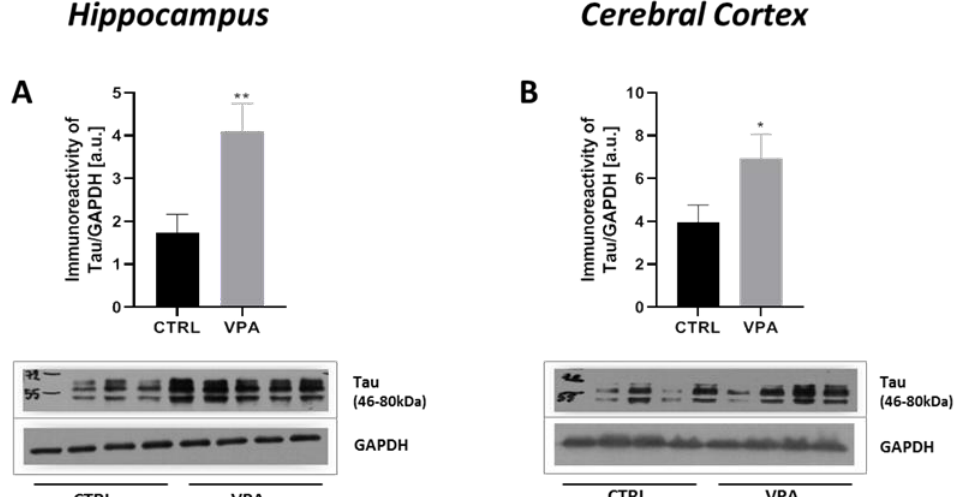
Figure 2. The effect of prenatal exposure to VPA on the protein level of total Tau in the rat brain. Immunoreactivity of total Tau in control and VPA-exposed rats was monitored using Western blot analysis. Densitometric analysis and representative pictures of total Tau in the hippocampus ( A ) and cerebral cortex ( B ) were shown. Results were normalized to GAPDH levels. Data represent the mean values ± SEM from n = (8) independent experiments in both the hippocampus and cerebral cortex: ( A ) n = 8 (CTRL), n = 8 (VPA); ( B ) n = 8 (CTRL), n = 8 (VPA). * p < 0.5, ** p < 0.01, vs. control.